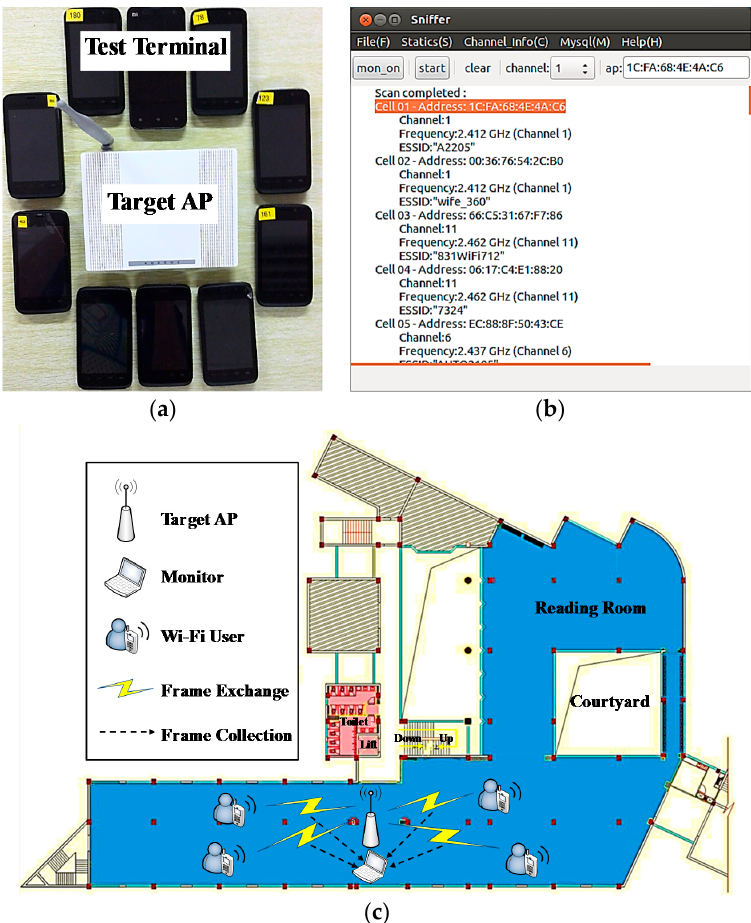
Figure 7. Experimental setup: ( a ) Experiment equipment; ( b ) The GUI of the monitor; ( c ) The floor plan of the experiment.